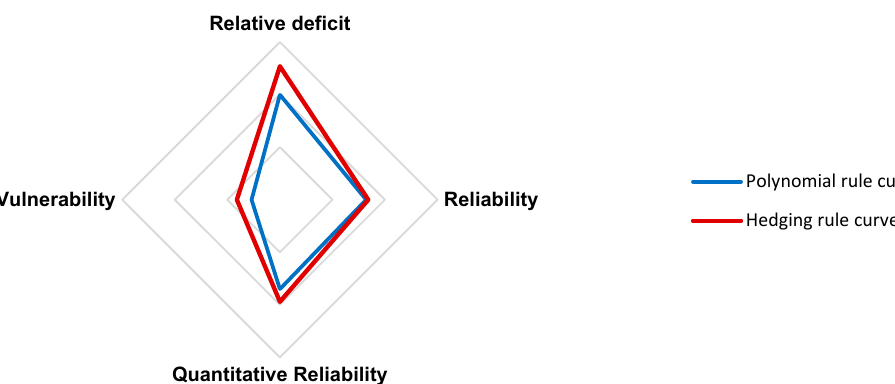
Figure 9. Variation of operational indices for completed rule.